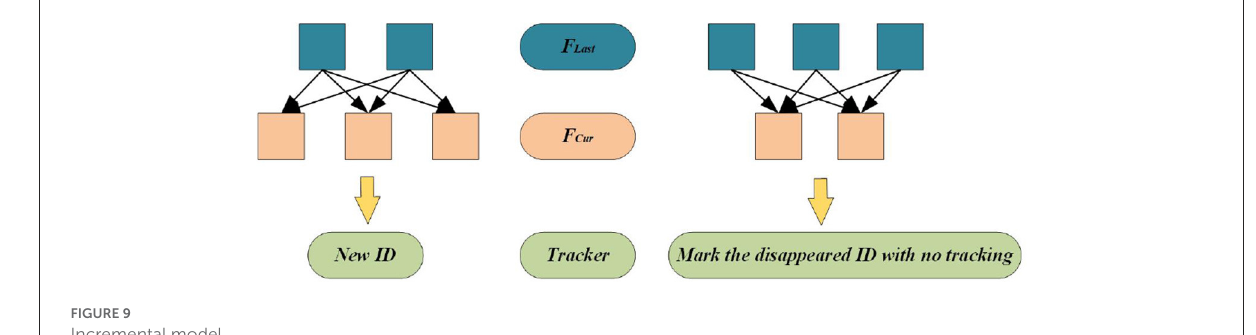
FIGURE9 Incremental model.